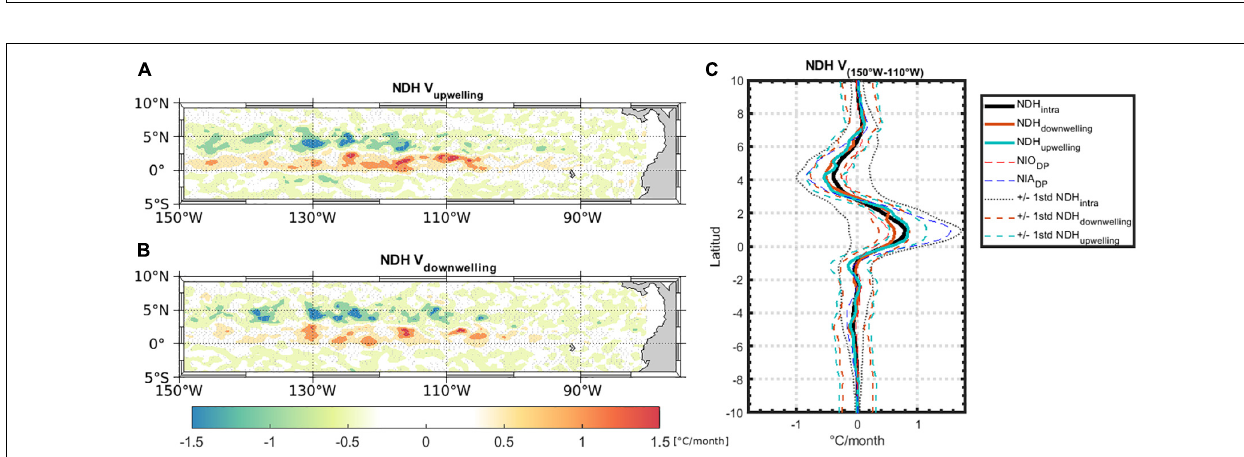
FIGURE 4 | Composites of SLA, meridional geostrophic velocity anomalies (arrows) and SST anomalies [red (blue) contours corresponds to 0.2 (-0.2) ◦ C] at the peak of a strong events in sea level anomalies (i.e., IKW) along the equator (cf. Figure 2A ) [ (A) for downwelling, (B) for upwelling].